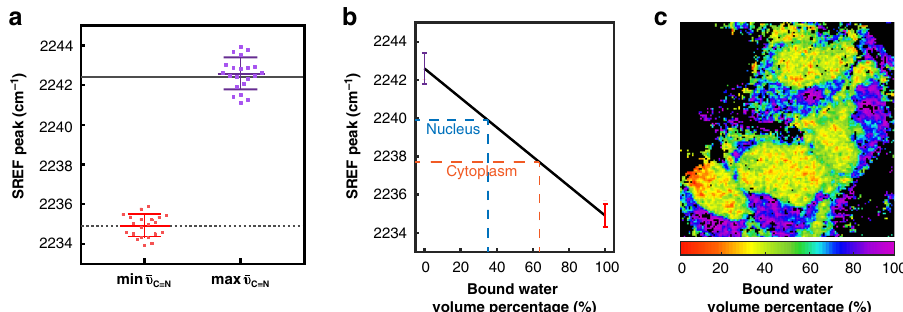
Fig. 5 Compositional map of intracellular water pool. a Averaged minimum and maximum SREF peak frequencies of C (cid:4) N on Rh800 in cells. The minimum (cid:1) ν (mean ± s.d.) is 2234.9 ± 0.6 cm − 1 and maximum (cid:1) ν (mean ± s.d.) is 2242.6 ± 0.8 cm − 1 averaged over 21 HeLa cells. Solid line and dashed line C (cid:4) N C (cid:4) N show in vitro (cid:1) ν in pure water (2242.4 cm − 1 ) and DMSO (2234.9 cm − 1 ), respectively. b Linear calibration curve between bound water volume C (cid:4) N percentage and the SREF peak frequency. c Intracellular map for the bound-water state: 64% in cytoplasm and 35% in nucleus on average were estimated from b . Error bars represent standard deviations for